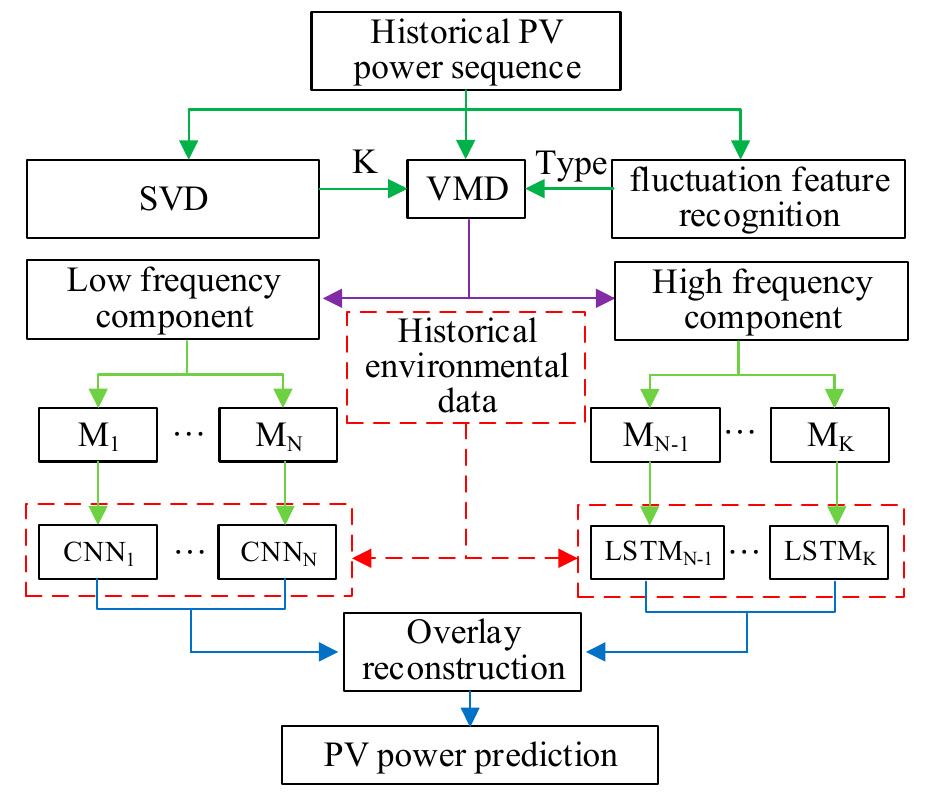
Figure 4. PV power prediction process.